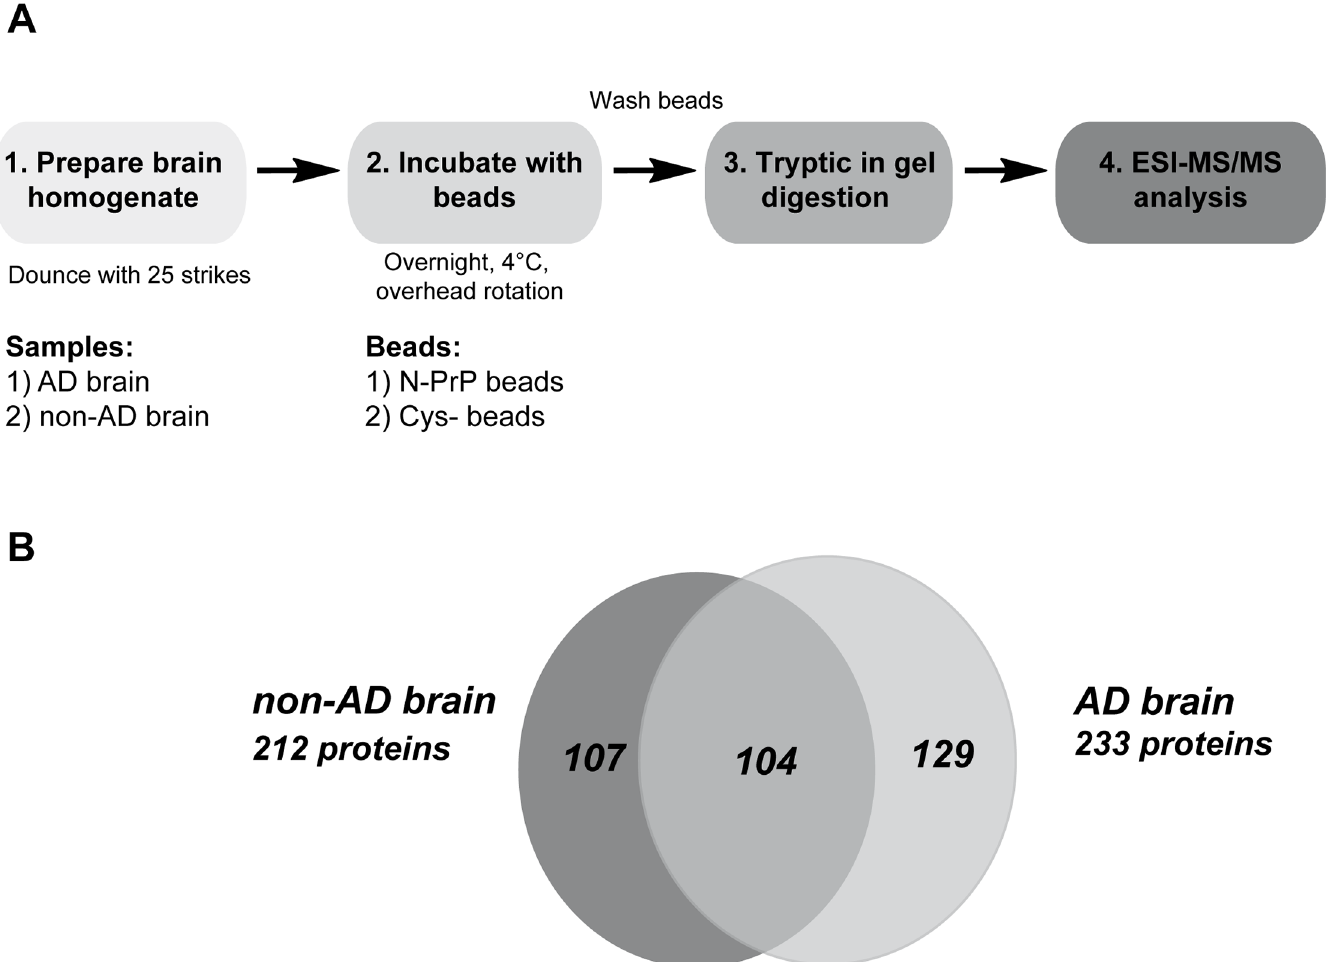
Fig 2. Characterization of N-PrP-interacting proteins. A. Schematic representation of the experimental approach. Parietal cortex samples of a non-AD and an AD brain were dissolved in lysis buffer (25% w/v) homogenized with 25 strikes in a glass douncer, and centrifuged (7,500 x g, 4˚C). The supernatant was added to the PrP23- 114 beads and incubated overnight at 4˚C. As a control, lysates were incubated with cysteine-modified beads. To purify interaction partners, beads were washed extensively in lysis buffer. Finally, beads were pelleted by centrifugation and boiled in SDS buffer. The SDS-soluble fraction was separated by SDS-PAGE and proteins co-purified with the beads were identified by ESI-MS/MS after tryptic in-gel digestion. B. Venn diagram of proteins interacting with PrP23-114 in non-AD and AD brain. The overlap represents PrP23-114-interacting proteins identified in both brain